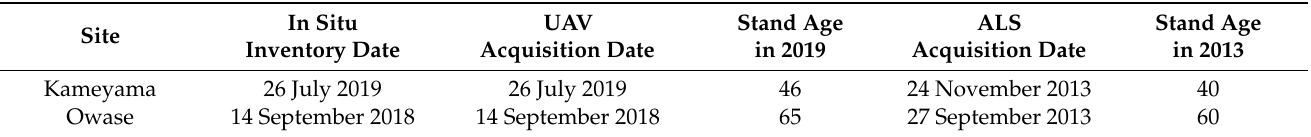
Table 1. Summary of data collection with ALS, UAV, and in situ